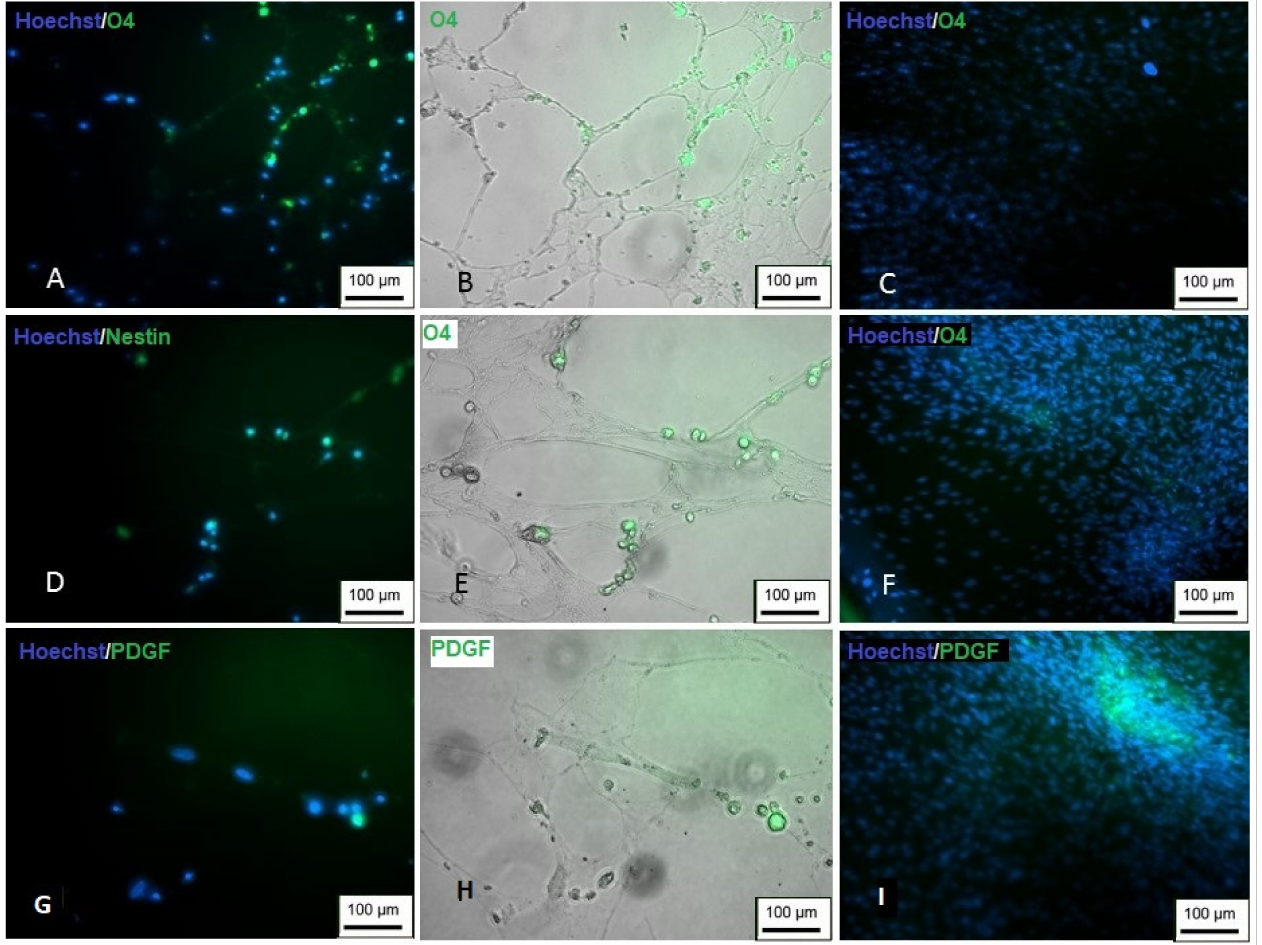
Figure 21. Immunocytochemistry of differentiation in oligodendrocytes. ( A , B ) Cells showing positive staining for O4 (green); ( C ) undifferentiated control; ( D , E ) positive staining for Nestin (green); ( F ) undifferentiated control; ( G , H ) positive staining for PDGF (green); ( I ) undifferentiated control (inversion optical microscopy—200 × ). Scale bar, 100 µ